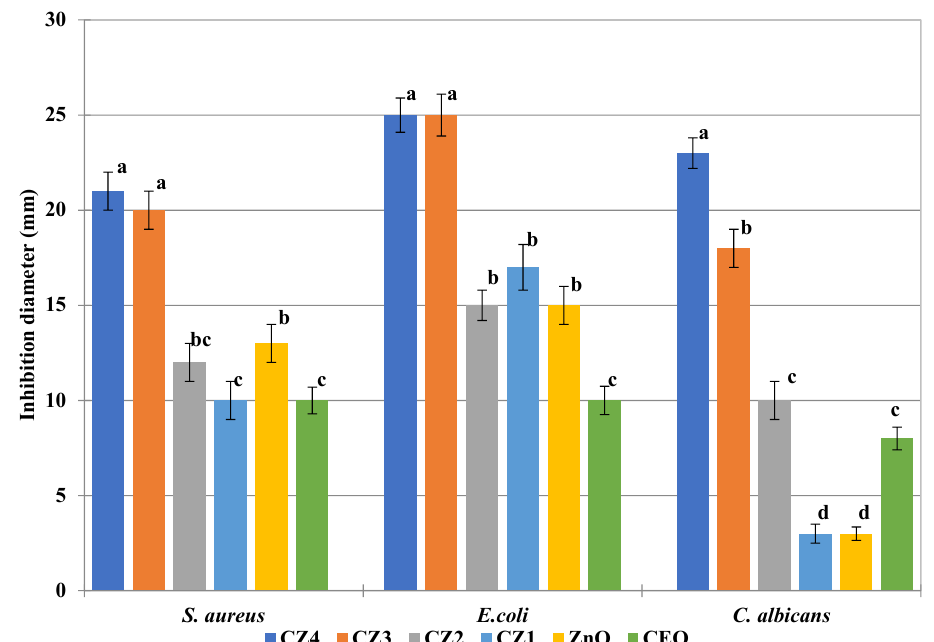
Figure 15. The antimicrobial activity of CZ1–CZ4 films and ZnO nanoparticles—different letters indicate statistically significant differences between films ( p < 0.05).